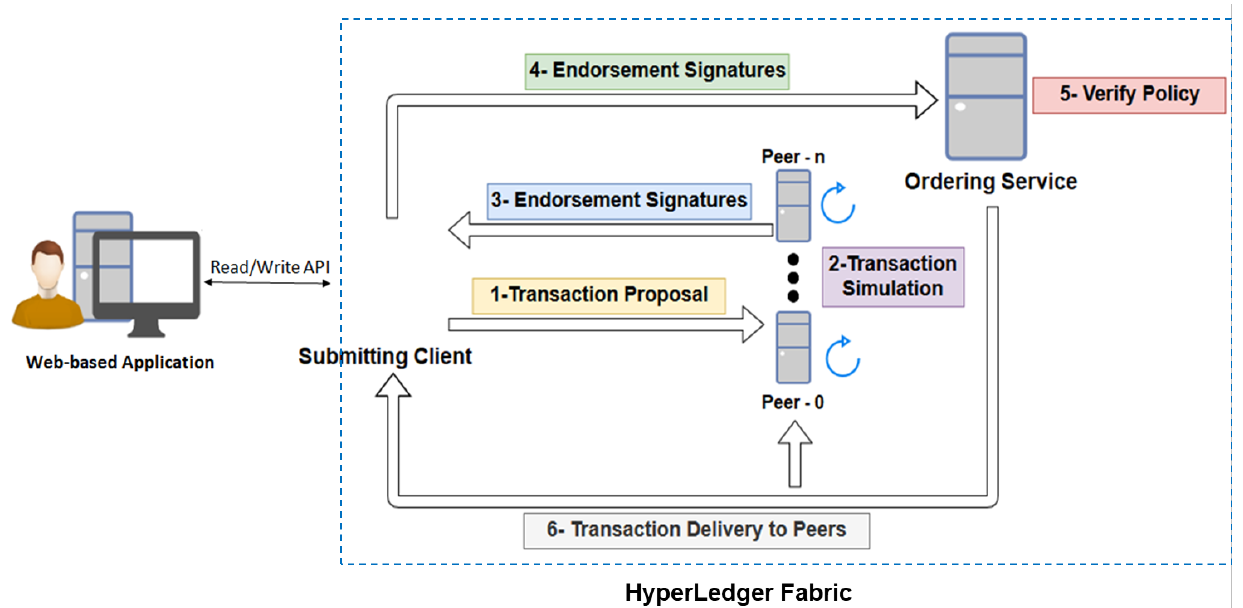
Figure 4. The structure and flow of the proposed distributed framework for automotive supply chain management.